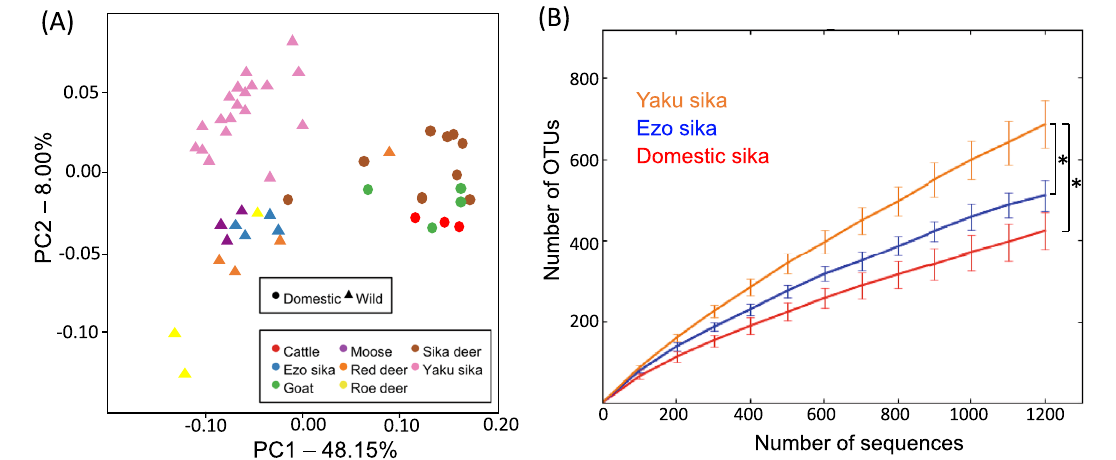
Figure 3. ( A ) PCoA based on weighted UniFrac distance among ruminants. The weighted UniFrac distance was tested using permutational multivariate analysis of variance. ( B ) Rarefaction curves of 16S rRNA OTUs among sika deer. The number of OTUs of Yaku sika rumen bacterial microbiota was compared to those of Ezo sika and domestic sika deer. * P ≤